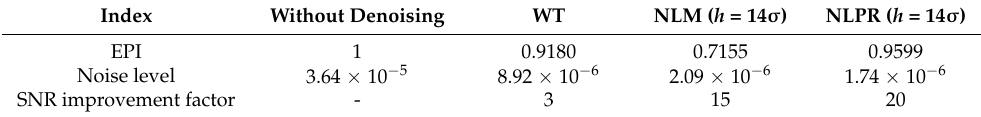
Figure 9. Multi-component gas calibration results. Denoised data: PA amplitudes processed by NLPR denoising. ( a ) C 2 H 2 signals vs. concentration; ( b ) H 2 O signals vs. concentration. ( c ) CO 2 signals vs. concentration. Table 3. Evaluation results of multi-component gas spectrum using different denoising